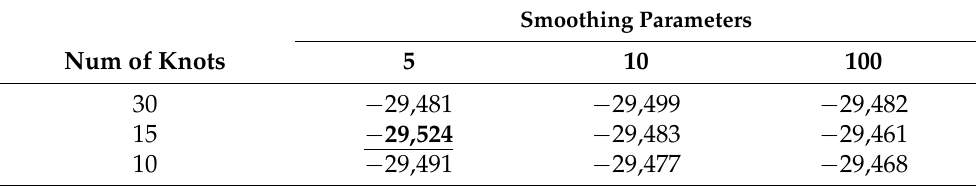
The best of each distribution is underlined, and the best overall is in bold. Table 26. Estimated parameters about limit order book (4 January 2016, JAL, Tokyo, Japan). Parameters